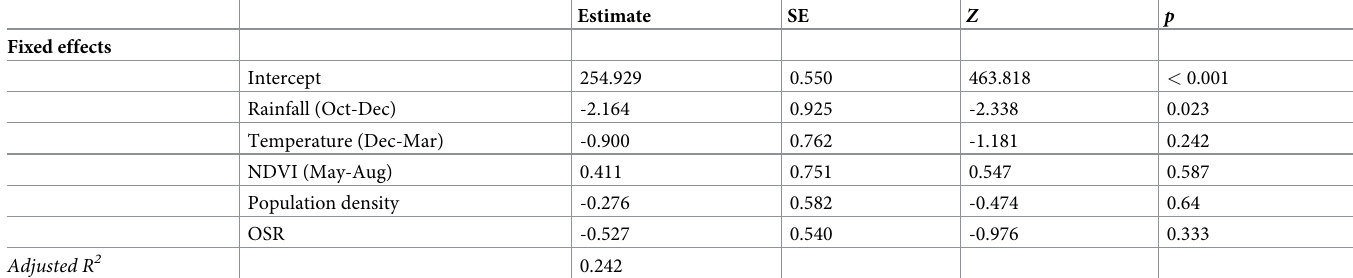
Table 2. Linear model for the response variable rut peak (a date in September) and the fixed factors rainfall (previous year October-December), temperature (previ- ous December-March), NDVI (previous May-August), population density and Operational Sex Ratio (OSR).